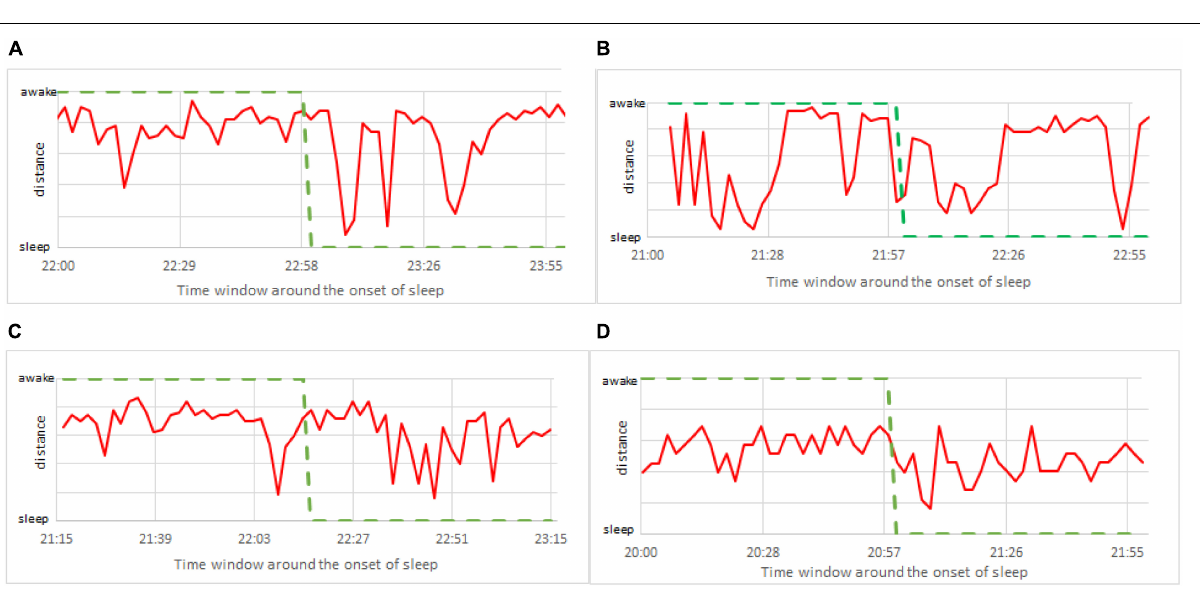
FIGURE 11 | Zoom to the onset of sleep as in Figure 10 , but this time calculated via 50 randomly chosen shapelets as described in the text (not via single best shapelet). The consciousness status is no longer binary (0 or 1), but a continuous value ranging between sleep (0) and awake (1). (A) Male subject, 21 years of